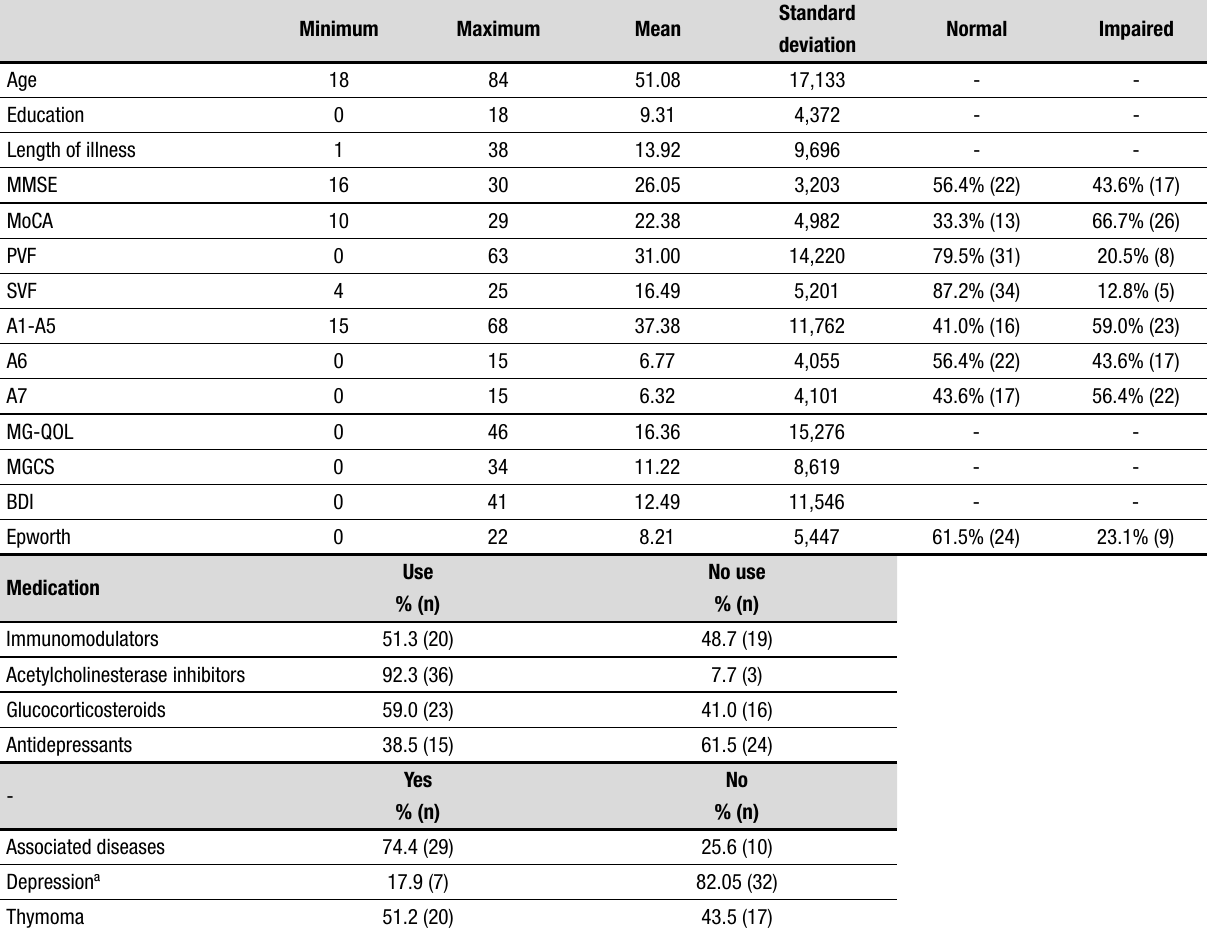
Table 1. Descriptive analysis of contextual variables and cognitive